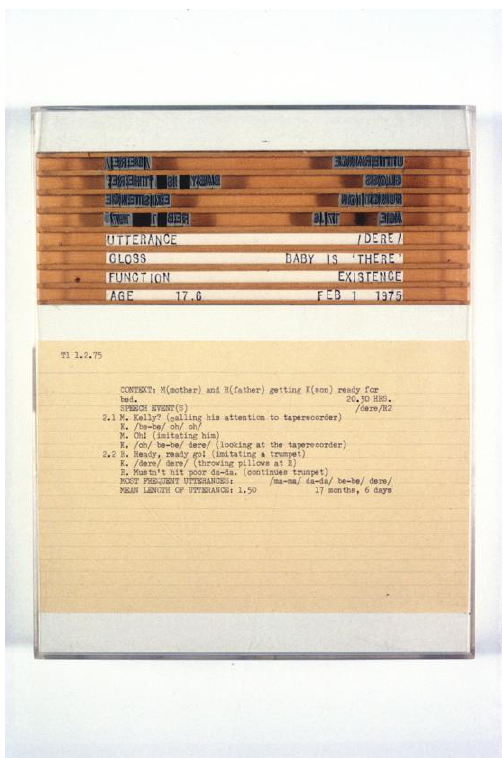
Figure 4: Mary Kelly Post-Partum Document, Documentation II, Analysed Utterances and Related Speech Events. 1975, (detail, 1 of